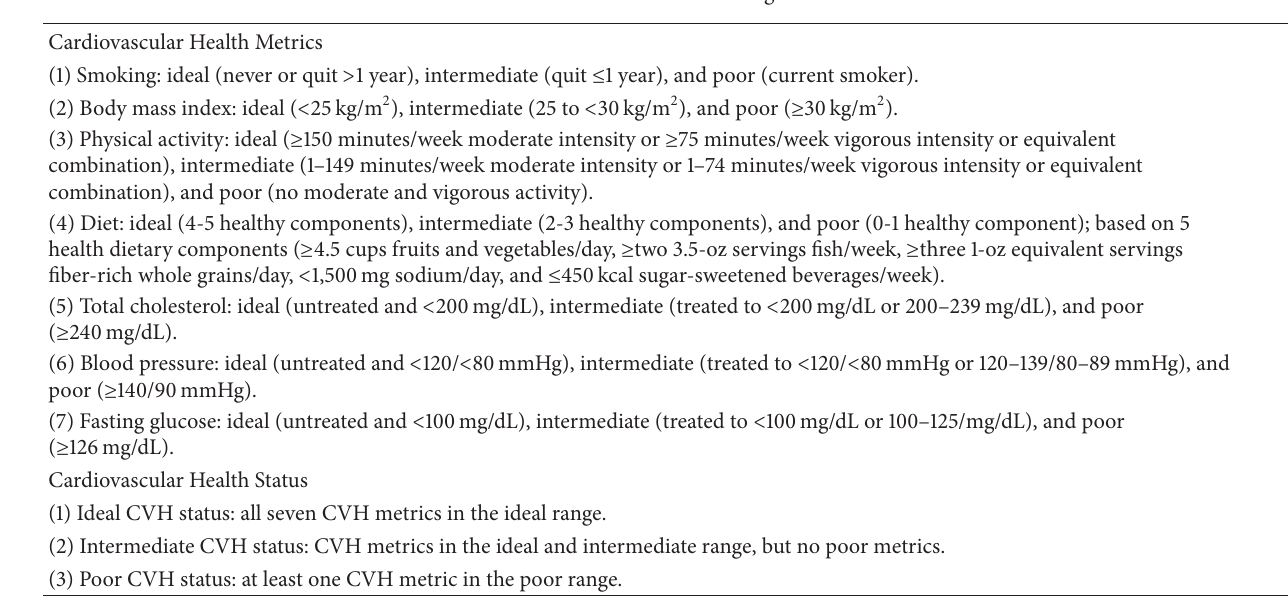
Table 3: Cardiovascular health metrics and status according to the American Heart Association. Cardiovascular Health